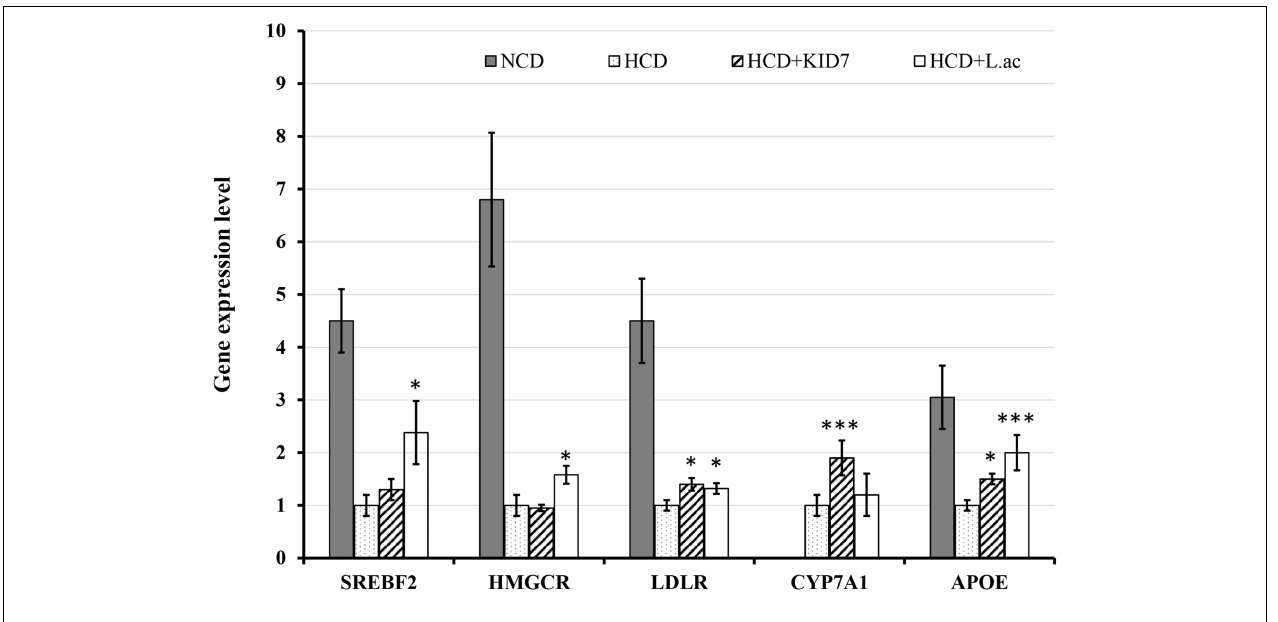
1.0. NCD: normal diet; HCD: high-cholesterol diet; HCD-KID7: HCD + P. pentosaceus KID7; HCD- L.ac : HCD + L. acidophilus . Data are expressed as means ± SEM ( n = 8 /group). * , *** indicate significantly higher at P < 0 . 05 and P < 0 . 005 , respectively, vs. the HCD